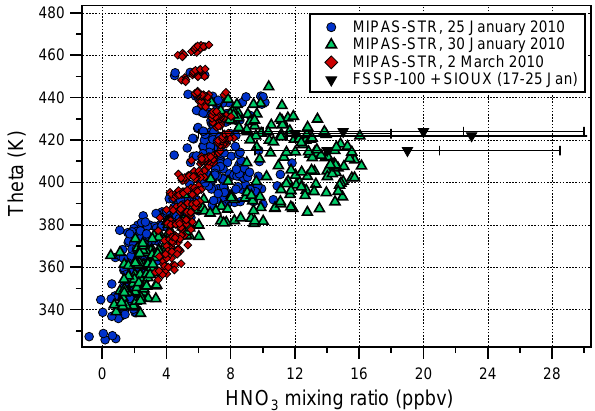
Figure 15. Gas-phase HNO 3 mixing ratios retrieved from MIPAS- STR observations (also operated on board the M-55 Geophysica ) vs. potential temperature. Enhanced HNO 3 mixing ratios are ob- served between 380 and 440K as a result of renitrification. The most prominent renitrification signal is found for 30 January 2010 (green) (i.e., just after the PSC season, as evident from Fig. 2) with about 9ppbv excess HNO 3 . Total HNO 3 mixing ratios (condensed plus gas phase) derived from the FSSP-100 measurements together with measured SIOUX in situ gas-phase HNO 3 partly lie within the range of MIPAS-STR and partly exceed these values. (In the case of no available SIOUX data, lower and upper limits of 2 to 7ppbv were used.) The error bars for the FSSP + SIOUX-derived mixing ratios are estimated at